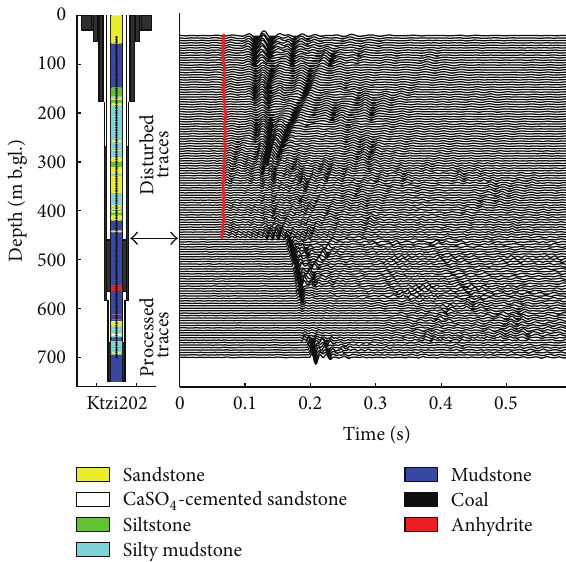
Figure 3: Vertical component of the baseline zero-offset VSP together with the casing of Ktzi202 and the lithology within the well (modified after Daley et al. [25]). Left: casing and cementation (grey) of Ktzi202; the lithology is plotted in the centre of the well [21]. Right: zero-offset VSP, vertical component with trace balance, and linear moveout with 6100 m/s steel velocity [28]. The first breaks in the upper part are marked with red dots.